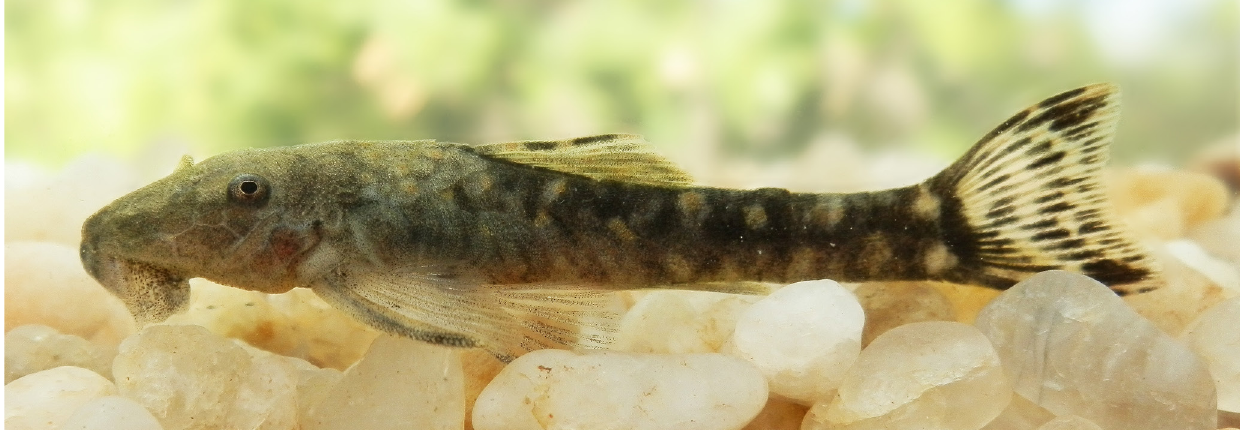
Fig. 2. Parotocinclus seridoensis , live paratype specimen, UFRN 240, 30.6 mm SL, from rio Seridó (type locality), Caicó, Rio Grande do Norte, just after